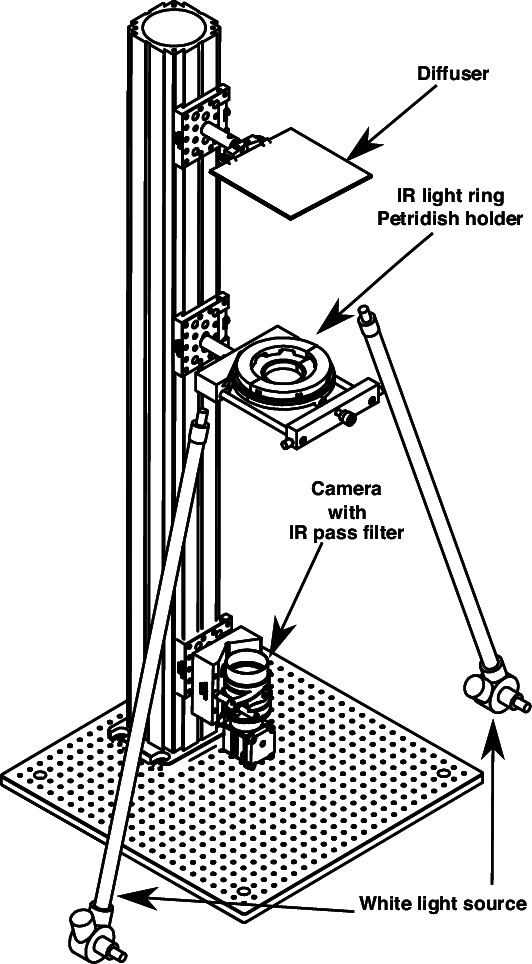
Behavior imaging system.Behavior is recorded from below a 35 mm petridish arena, with the camera connected to custom software such that after triggering a default recording event at the start experiment, subsequent recordings events are triggered when the larva is within a circular region of interest (ROI). An a long-pass filter is fitted on the camera lens, and a custom IR light-ring illuminates the arena uniformly. Diffused light is used to illuminate the arena, that obtained via lab-bench light-source pointing upwards onto a frosted glass that sits above the arena. The event ROI is set such that Behavior is recorded only when larval is sufficiently away from the edge of the petridish. The recording session timeout is 10 min, beyond which time new recording events are not triggered. The maximum duration of recording events is limited to two mins. If the larva is still in the ROI after those 2 min, and the maximum experimental period (10 min) timeout has not been exceeded, then a new recording event is initiated.